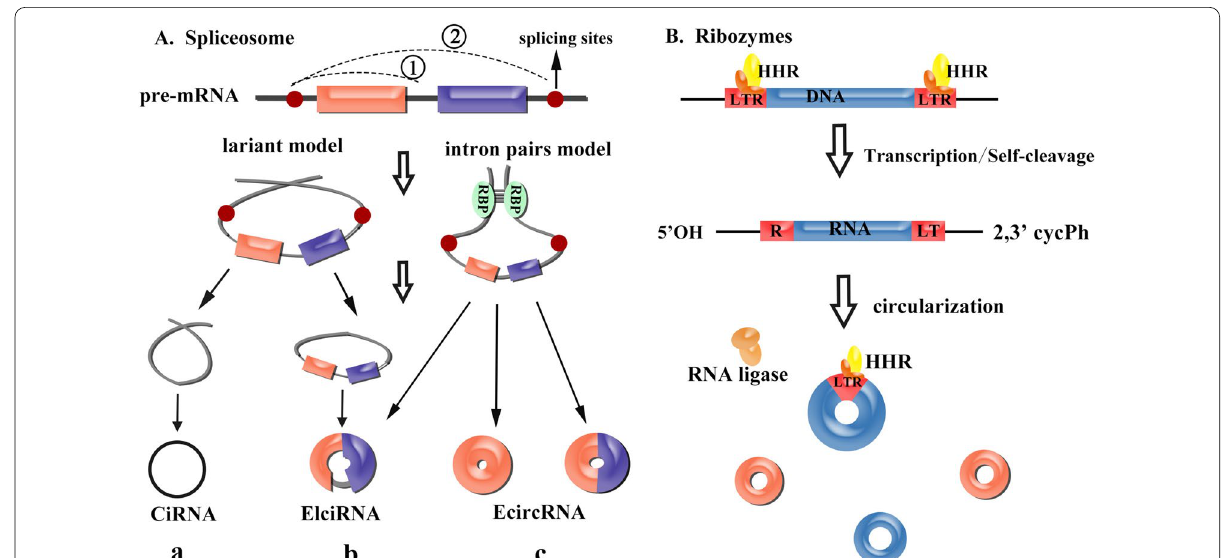
Fig. 1 Biogenesis of circRNAs. A Lariat-Driven Circularization model and Intron-Driven Circularization model. The former produces a lariat because of exon skipping. The lariat makes the splicing sites of circularized exons closer than before. Then, the lariat is cut again by the exons; in this way, a circRNA and a free lariat composed of introns are produced. The latter reveals that repetitive and reverse complementary sequences in flanking introns form a stem-loop structure, which brings the splicing sites into spatial proximity. Based on composition, circRNAs are divided into 4 types including (a) CiRNAs formed by introns merely, (b) EIciRNAs with both exons and introns inside the circular structure and (c) EcircRNAs with only exons to circularize. In addition, assume that one splicing site is stationary then alternative back splicing can produce two different circRNAs, as shown in dotted lines. Products of ① corresponds to the left one in (c) and ② corresponds to the right one. B Hammerhead ribozymes (HHRs) are embedded in direct long terminal repeats (LTRs) of DNA. After transcribed into RNA, HHR catalyzes the formation of 5’OH and 2,3 ′ cycPh. Then RNA ligase works to form the circular structure of linear